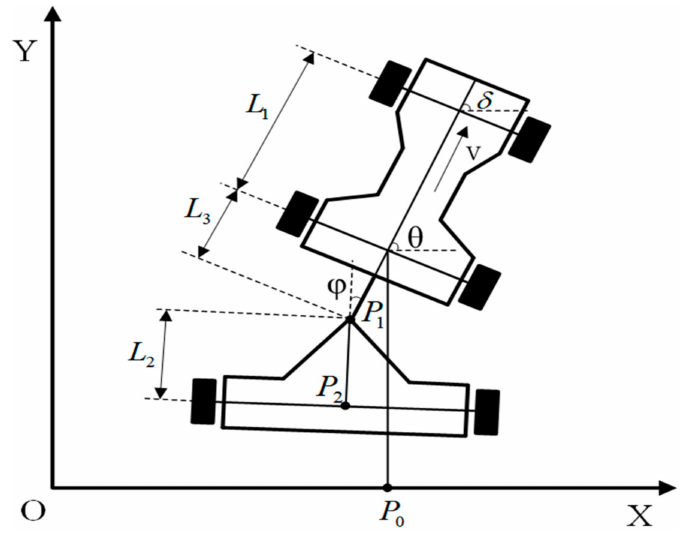
Figure 1. Schematic of tractor-trailer path